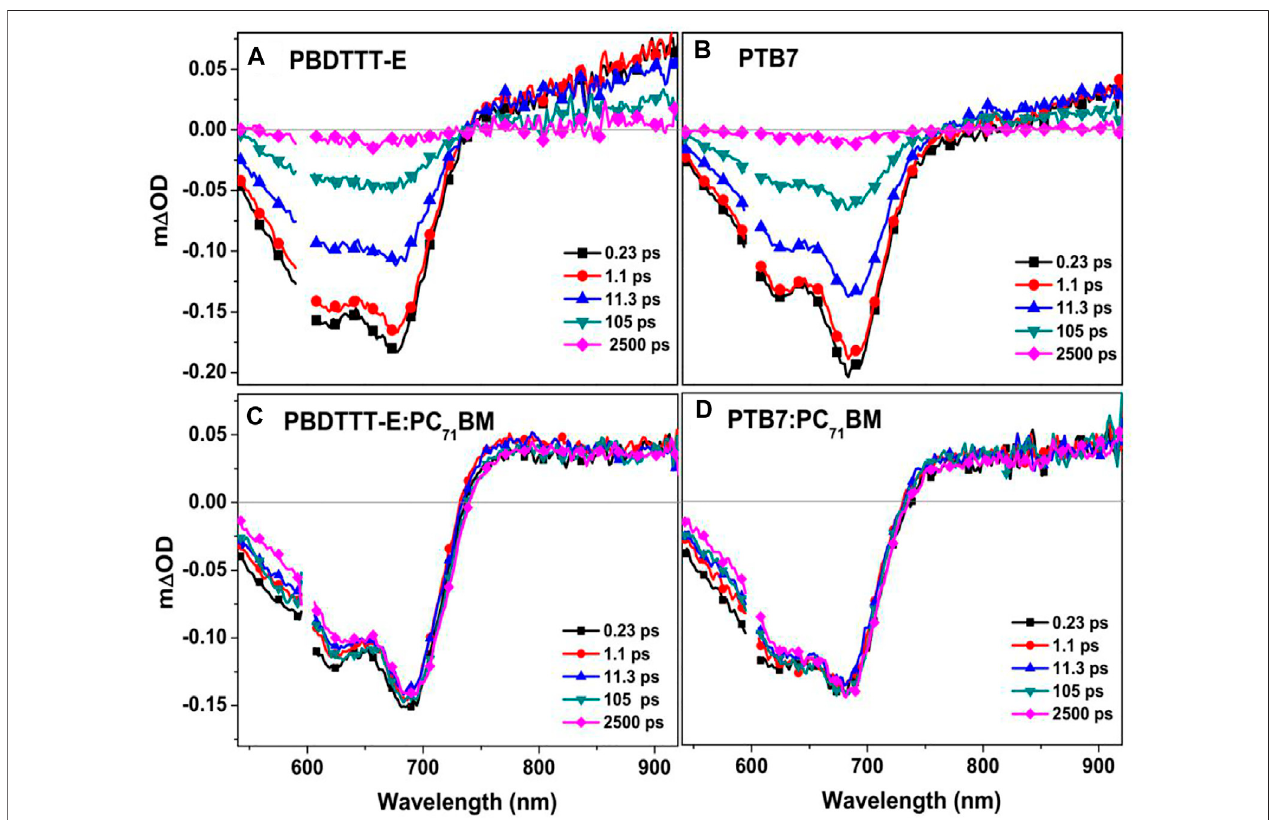
FIGURE 6 | Transient absorption spectra of (A) PBDTTT-E, (B) PTB7, (C) PBDTTT-E:PC 71 BM, and (D) PTB7:PC 71 BM fi lms at the different delay times recorded after photoexcitation at 600 nm under an excitation fl uency of 2.18 × 10 13 photons